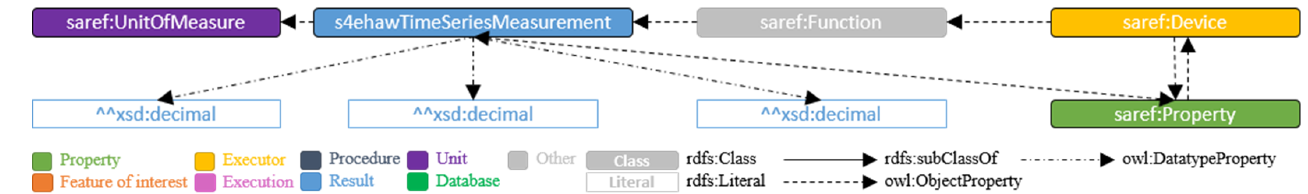
Figure 14. SAREF combines the result and execution class into saref:Measurement.